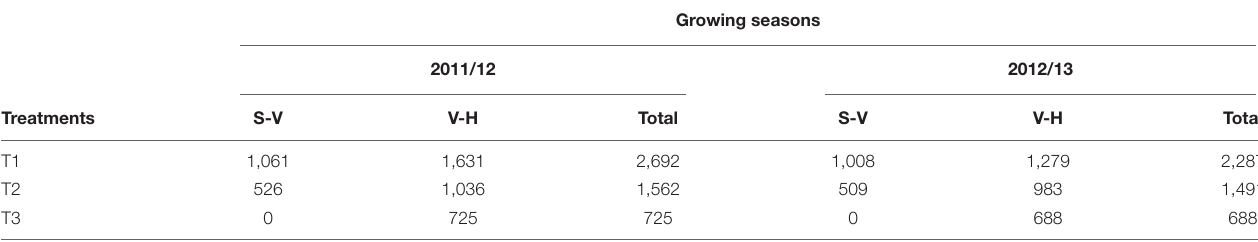
TABLE 3 | Water application (m 3 ha − 1 ) from setting (S) to veraison (V) and V to harvest (H) for a drip-irrigated Carménère vineyard.